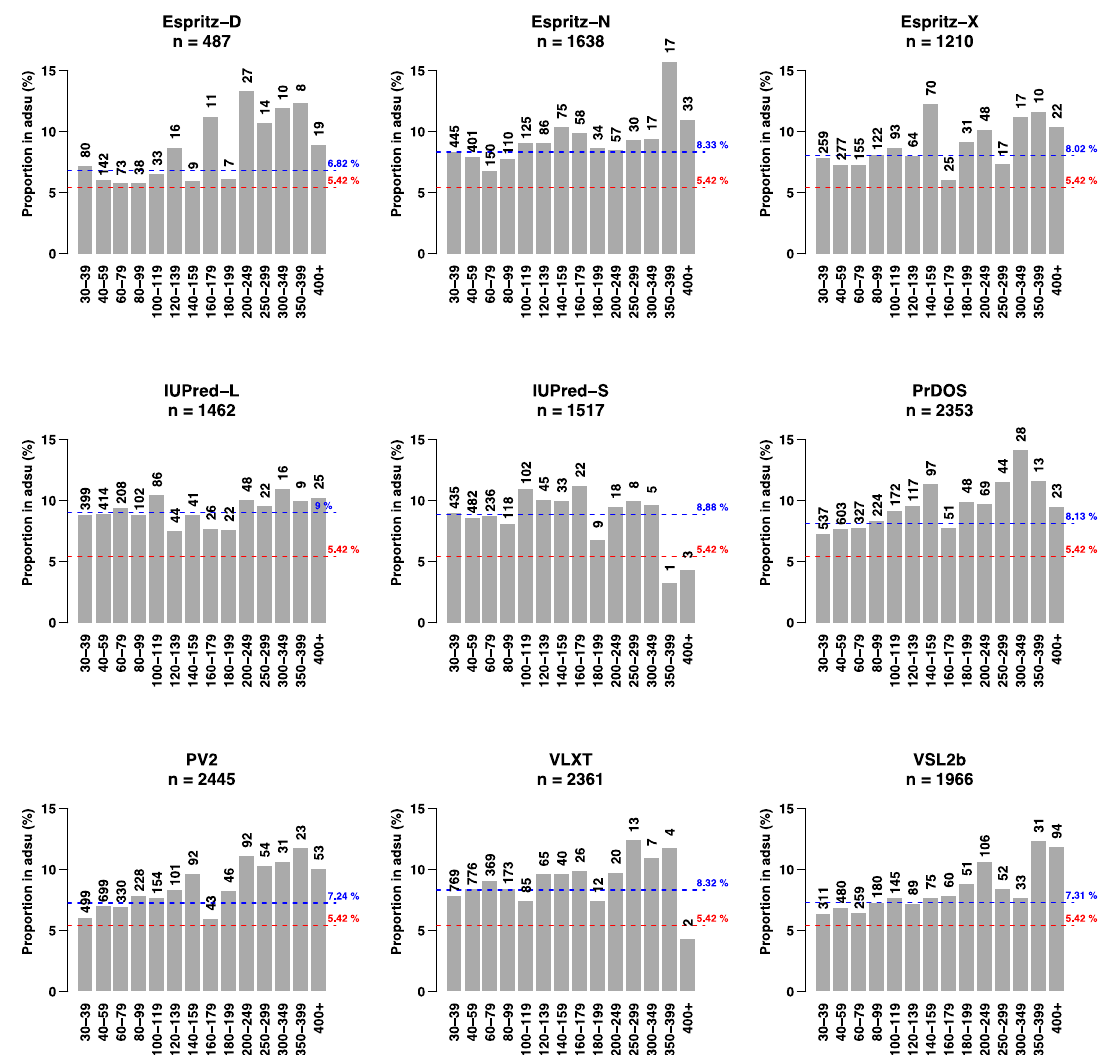
Figure 1. Enrichment of intrinsically disordered regions (IDRs) in proteins encoded by genes that are differentially expressed in lymphoma cells upon adhering to stromal cells. The number ( n ) of IDRs ( ≥ 30 residues) for each predictor is shown as well as how the detected IDRs are distributed in relation to length. The number of IDRs in each size category is shown. The blue line shows the percentage of all IDRs encoded by adhesion-related genes (adsu) and non-adhesion-related genes (nadsu) that are associated with the adsu set, while the red line shows the percentage expected if IDRs are equally distributed between the adsu and nadsu sets.